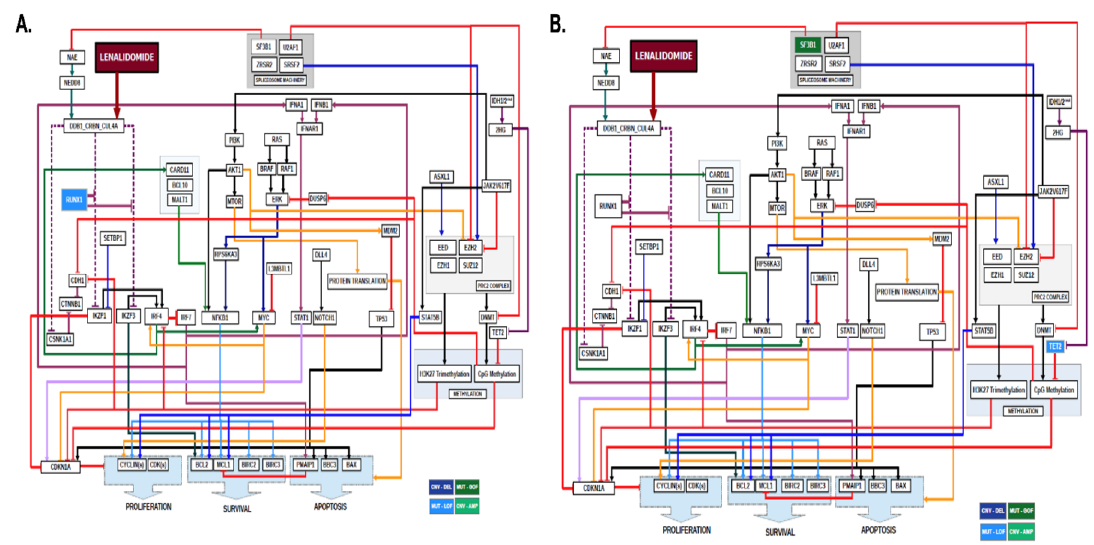
Figure 5. Computational Models of Non-Del(5q) MDS Patients with Genetic Mutations and Uninformative Karyotype. MDS patient-specific gene copy number variations, gain-of-function gene mutations, and loss-of-function gene mutations were computationally modeled and lenalidomide treatment digitally simulated. Two-dimensional maps showing intracellular pathways show the mechanisms of lenalidomide sensitivity in ( A ) RUNX1 mutant MDS. ( B ) Lenalidomide resistance was observed in non-del(5q) MDS cases harboring mutations in SF3B1 and TET2. Arrowed lines indicate agonistic relationship. Barred lines indicate antagnostic relationship. Line colorations are to assist the human eye in discriminating among the pathways. Somatic genes in dark blue boxes indicate copy number variation (CNV) deletions (DEL) derived from cytogenetic abnormalities. Somatic genes in light green indicate CNV amplifications (AMP) derived from cytogenetic abnormalities. Somatic genes with mutations resulting in loss of function (LOF) are indicated in light blue boxes. Somatic genes with mutations resulting in gain of function (GOF) are indicated in dark green boxes.